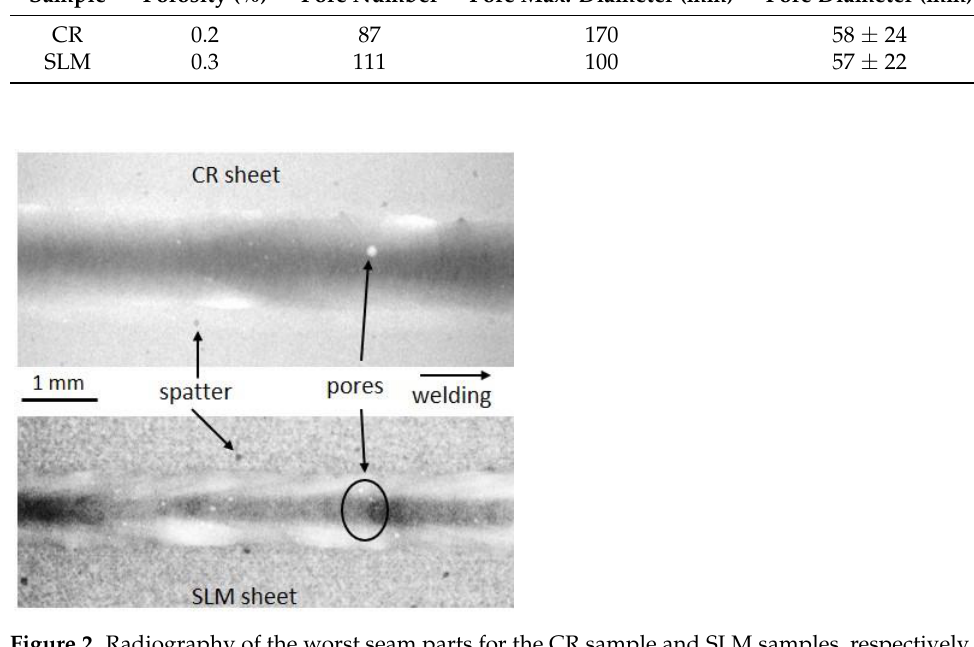
Table 4. Porosity analysis from X-ray radiography.